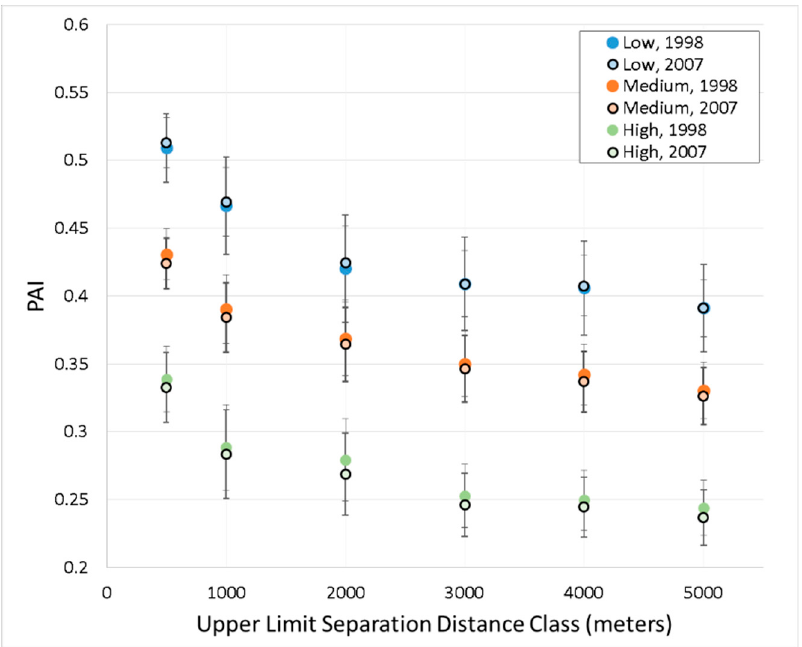
Figure 9. The relationship between three counties grouped by historical housing permit density levels (low, medium, and high), imagery date (1998 and 2007), and the fragmentation metric PAI across different separation distance classes.